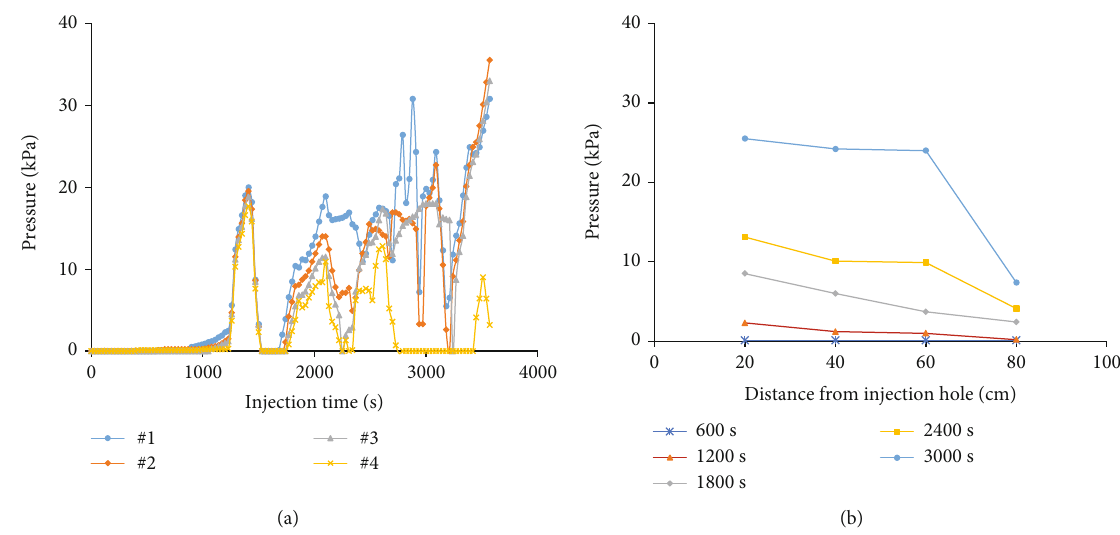
Figure 11: Slurry pressure as a function of (a) injection time and (b)